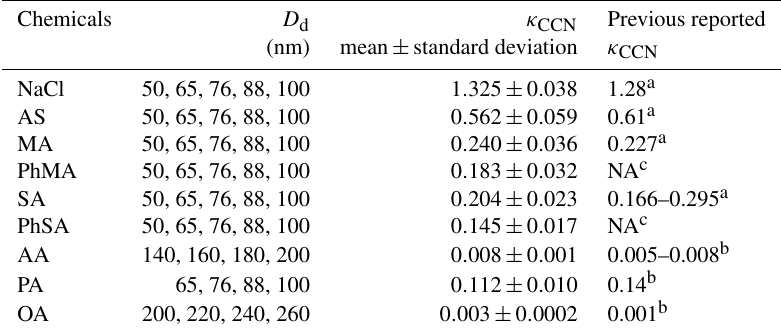
Table 2. Summary of κ CCN for single-component particles.